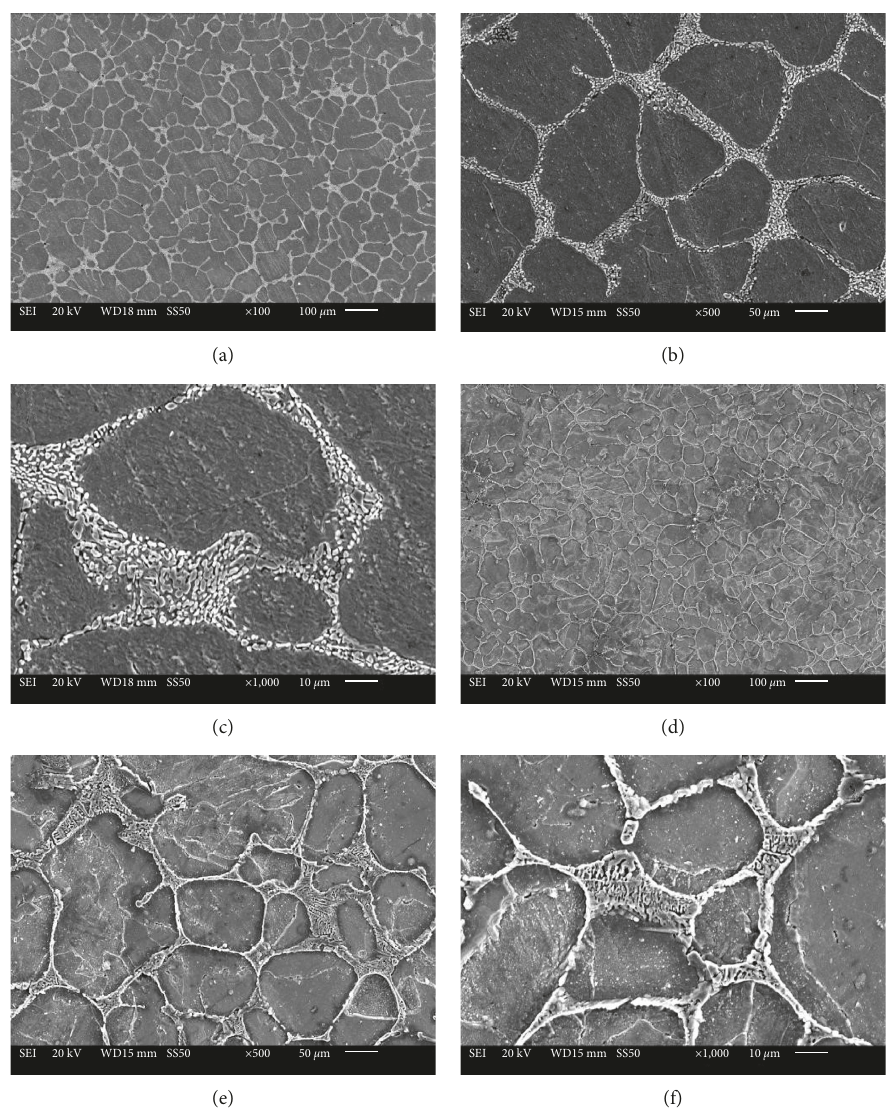
Figure 3: Solidification structure of the sample under the high undercooling conditions and ECP treatment. (a)–(c) Solidification structure of the sample under the high undercooling. (d)–(f) Solidification structure of the sample treated with the